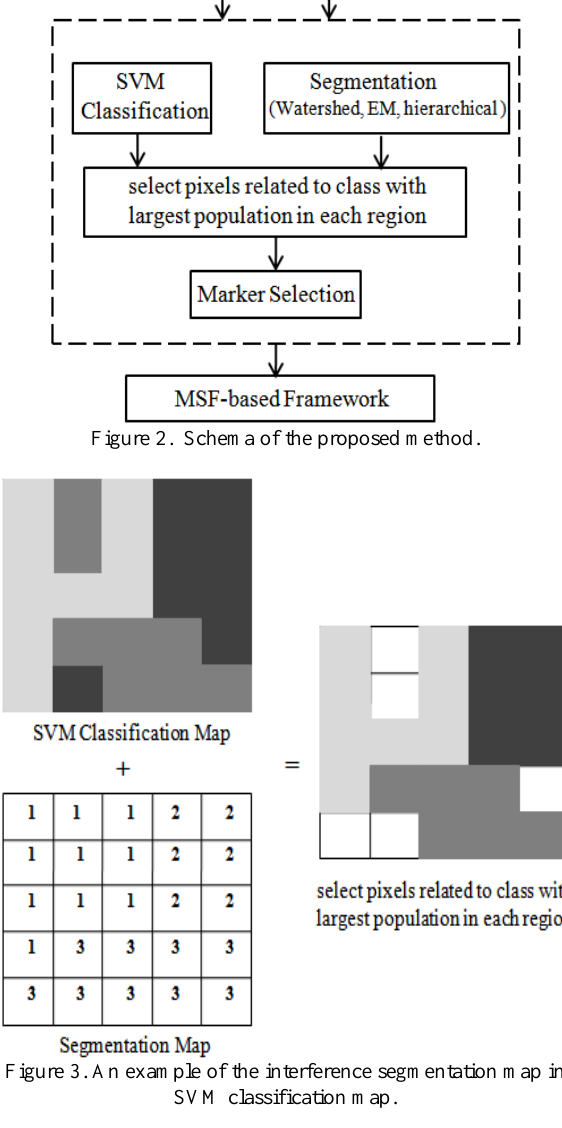
Figure 3. An example of the interference segmentation map in SVM classification